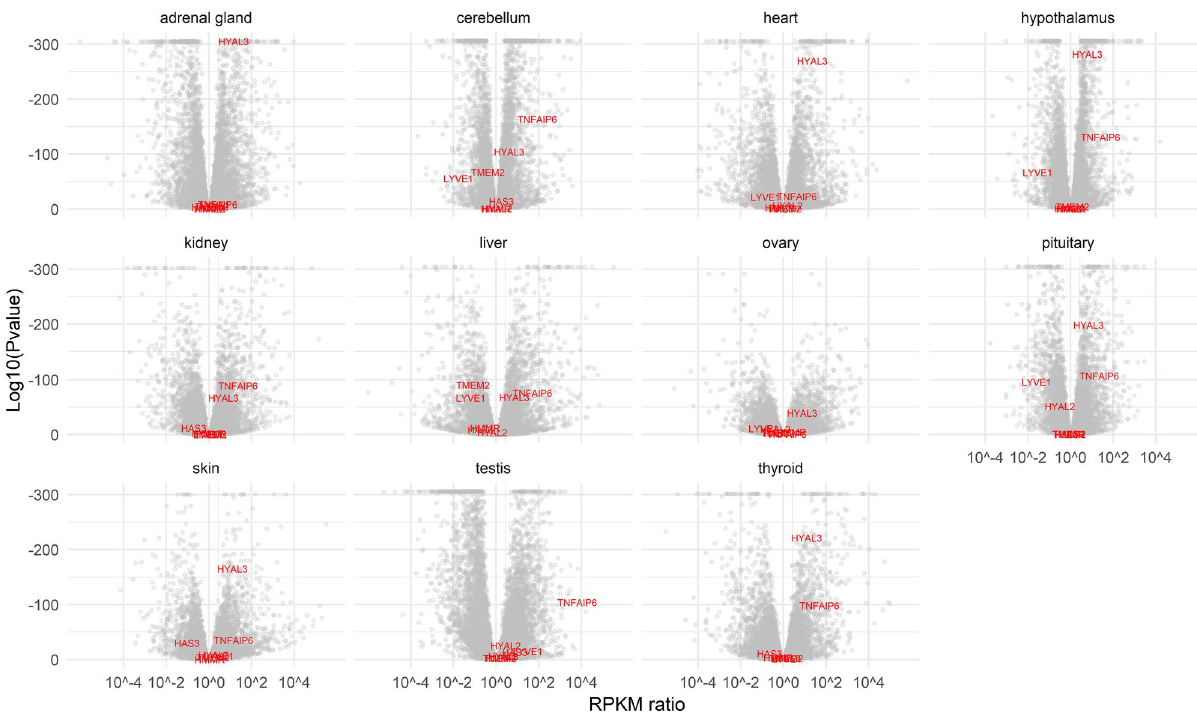
Figure 9. HA-family gene expression in NMR vs GP. Volcano plot of 6 HA-family genes ( Has3, Hmmr, Hyal2, Hyal3, Lyve1, Tmem2 and Tnfaip6 ), spotted in red on background of all other genes in grey, representing on y-axis, the statistical significance (log(P value)) vs, on x-axis, the magnitude of change (RPKM ratio) between NMR vs GP gene expression in 11 tissues (skin, heart, hypothalamus, testis, ovary, kidney, liver, thyroid, pituitary gland, cerebellum, adrenal